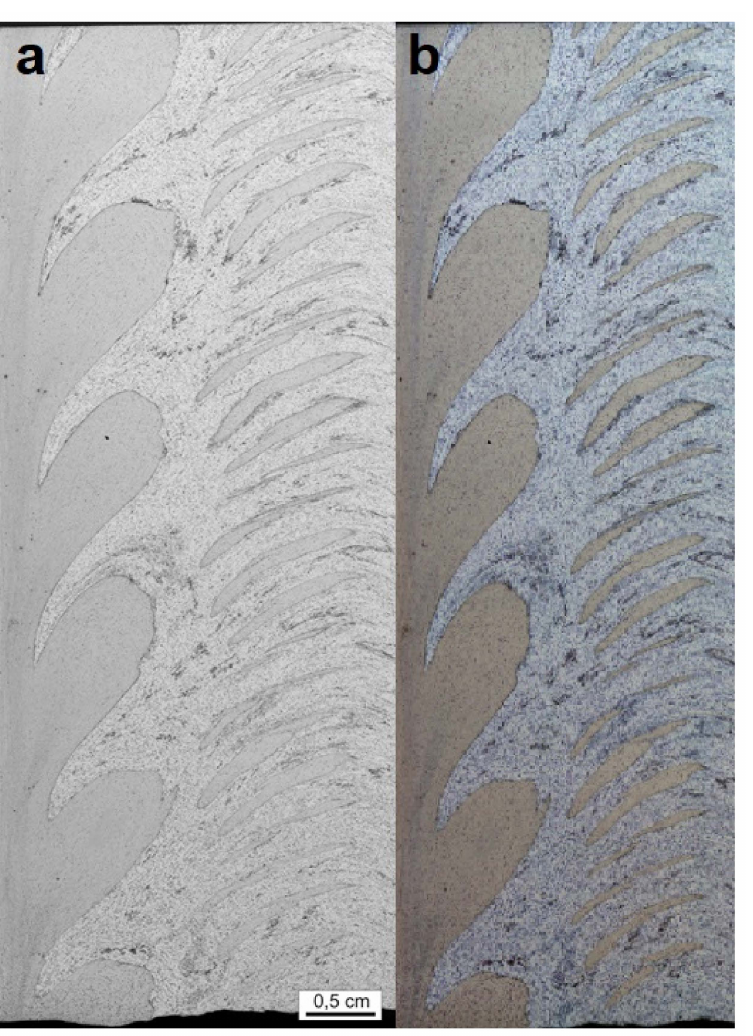
Figure 13. Abrasions visible in the microstructure: ( a ) an image without the square function transfor- mation; ( b ) an image after the square function transformation.